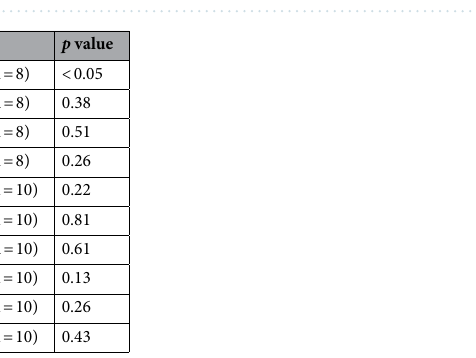
Figure 2. GABA A receptor-mediated inhibition in CA1 pyramidal neurons of Ube3a m−/p+ mice. ( A ) Representative recording traces of miniature inhibitory postsynaptic currents (mIPSCs) in CA1 pyramidal neurons of wild-type (WT) and Ube3a m-/p+ mice. ( B – C ) Comparison of the mIPSC frequency ( B ) and amplitude ( C ) between WT (n = 9 cells) and Ube3a m−/p+ (n = 10 cells) groups. ( D ) Representative current traces for evaluating tonic GABA A receptor-mediated inhibition in CA1 pyramidal neurons. The tonic current amplitude was determined as the baseline current shift induced by focal application of SR95531 (10 μM). € Comparison of the tonic current amplitudes in WT (n = 10 cells) and Ube3a m−/p+ (n = 9 cells) mice. The tonic form of inhibition is significantly decreased in the Ube3a m−/p+ group. Data are presented as the mean ± SEM, * p < 0.05, ns not significant by the unpaired t test.